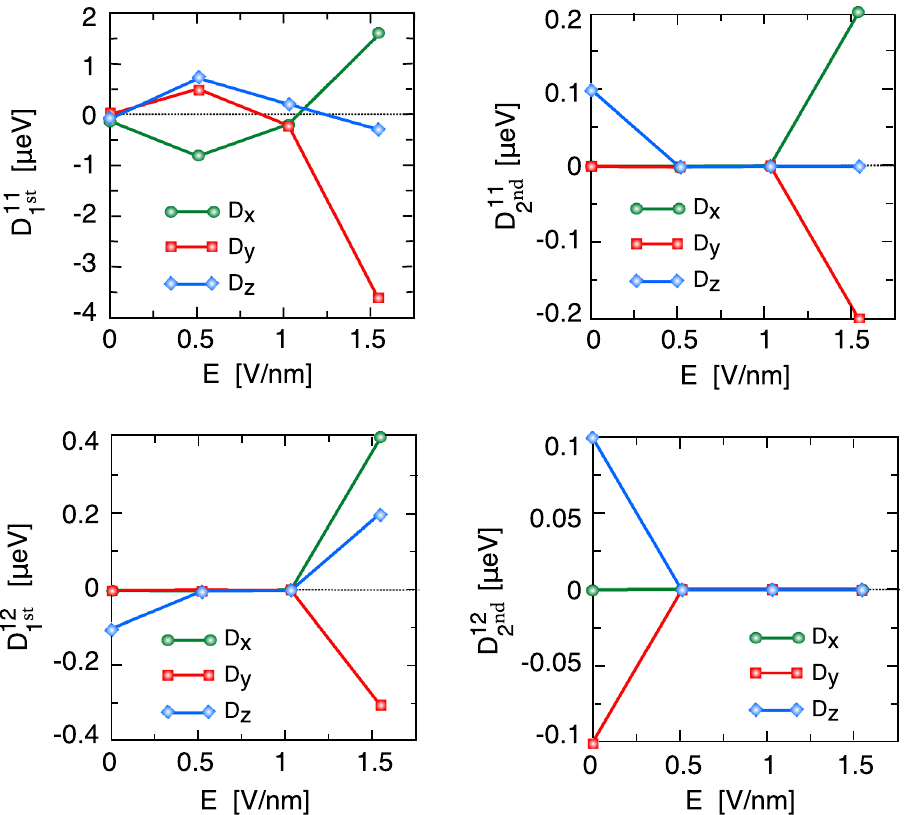
Figure 8. (Color online) First- (left) and second-neighbor (right) components of the intralayer (top panel) and interlayer (bottom panel) DMIs of bilayer CrCl 3 as a function of electric field. In the presence of an electric field, the D x and D y components of the NNN intralayer DMI increase, while D z